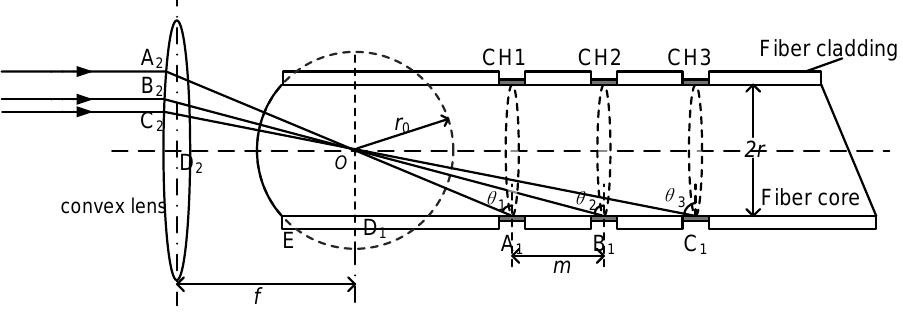
Figure 6. Proposed design of a novel multi-channel fiber-optic SPR